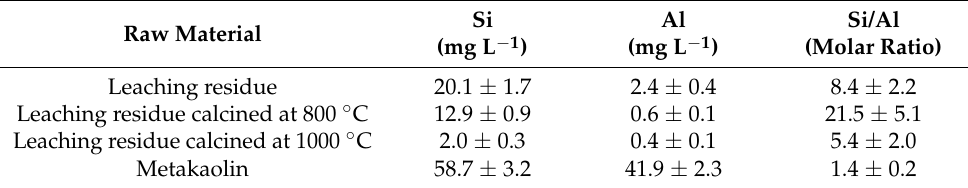
Table 3. Concentration of Si, Al, and Si/Al molar ratios in the